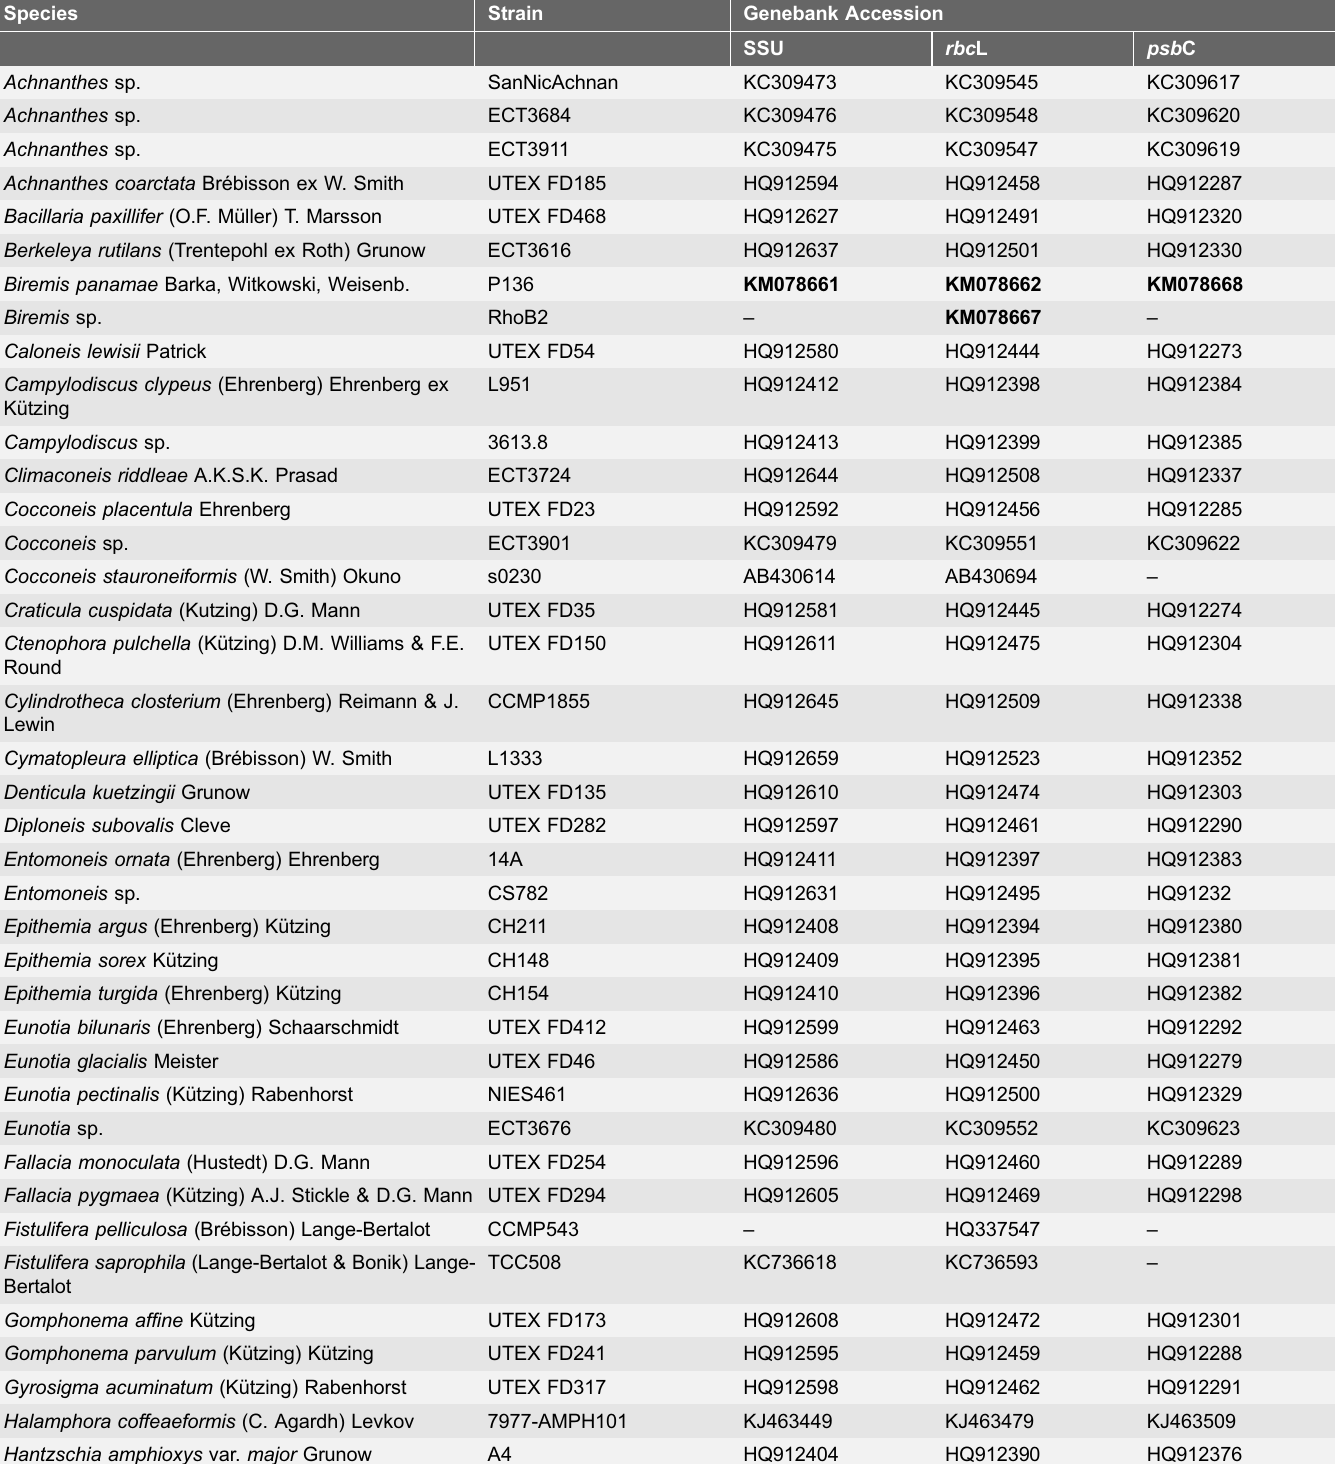
Table 2. GenBank accession of SSU rDNA, rbc L and psb C sequences derived from the species used in the phylogenetic analysis.